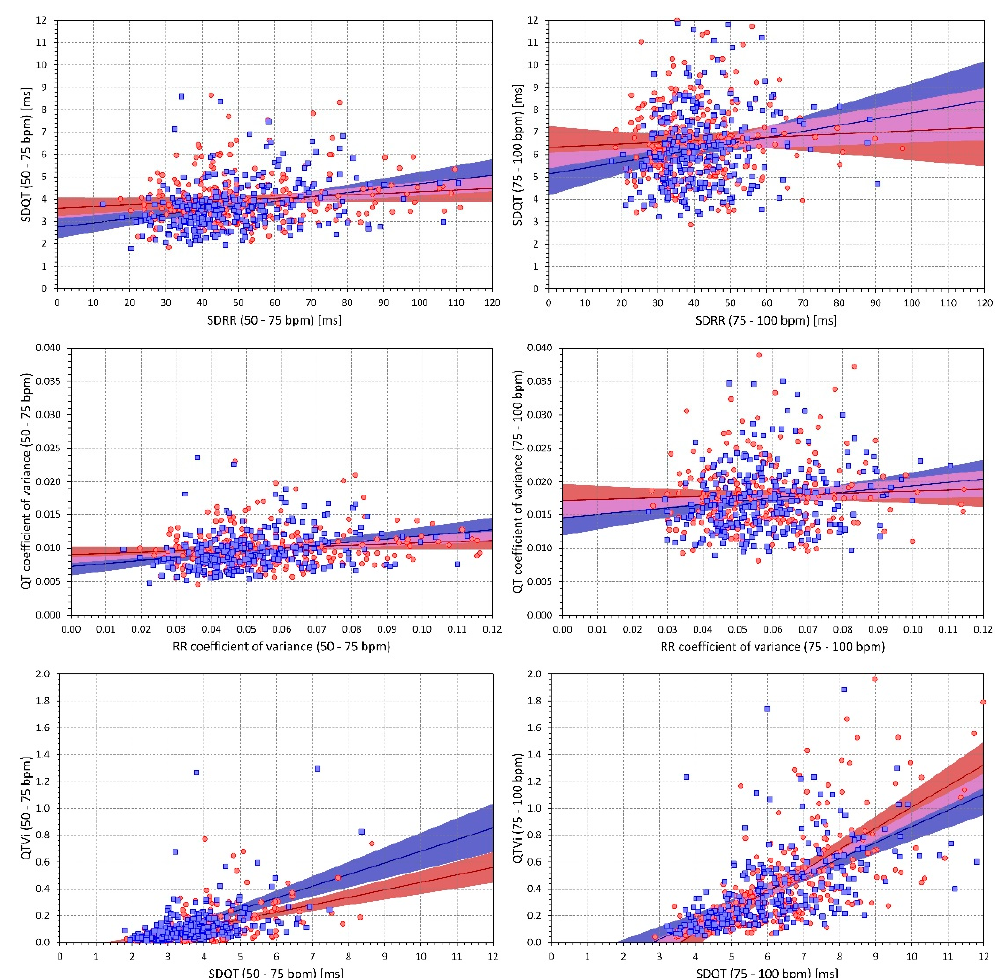
Figure 5. Inter-subject relationship of the measured indices. Scatter diagrams of the inter-subject relationships between intra-subject means of SDRR and SDQT (panels on the top), RR cvar and QT cvar (panels in the middle), and SDQT and QT variability index (panels at the bottom). Panels at the left and on the right show the indices calculated over ECGs with heart rates 50–75 bpm and 75–100 bpm, respectively. In each panel, the red circles and blue squares correspond to female and male subjects, respectively. The solid red and solid blue lines show the linear regressions between the intra-subject mean values of the compared indices. The red shaded and blue shaded areas are the 95% confidence bands of the regression lines; the violet areas are the overlaps between the confidence bands of the sex-specific regressions.